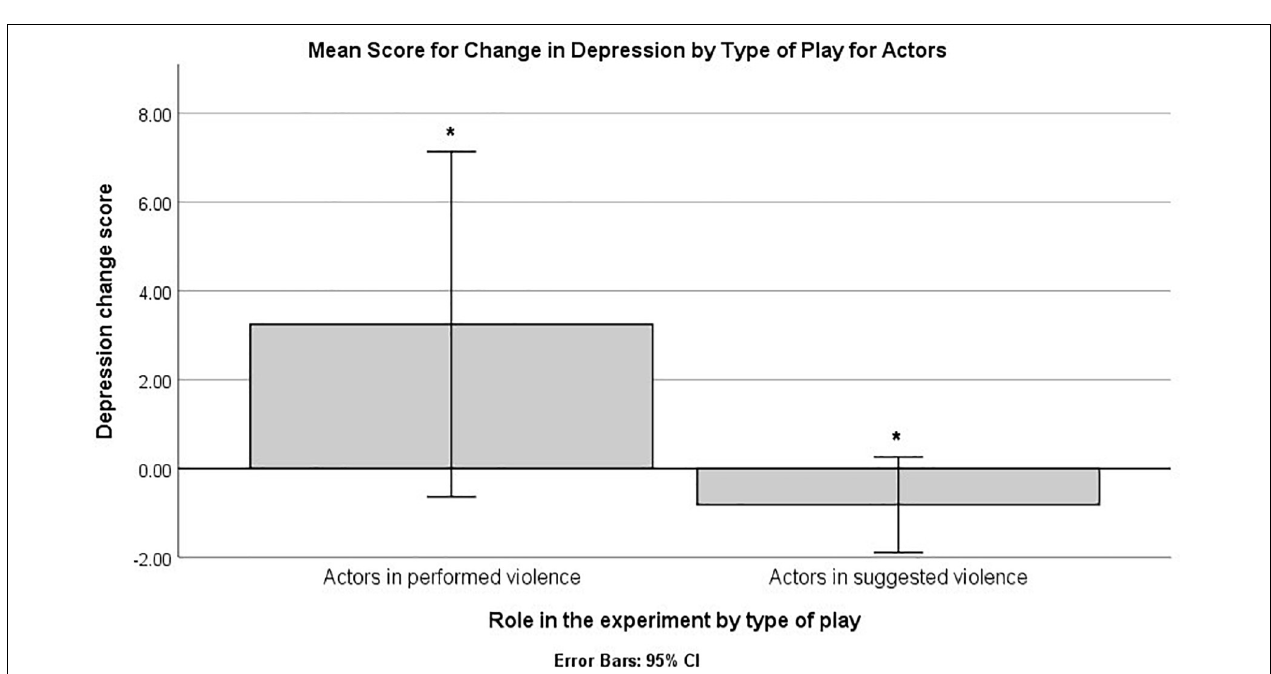
FIGURE 2 | Mean scores for depression change scores by type of play for actors in the experiment. The bars marked by “*” indicate statistically significant differences based on a non-parametric analysis and B–H procedure for controlling false discovery rate (FDR).